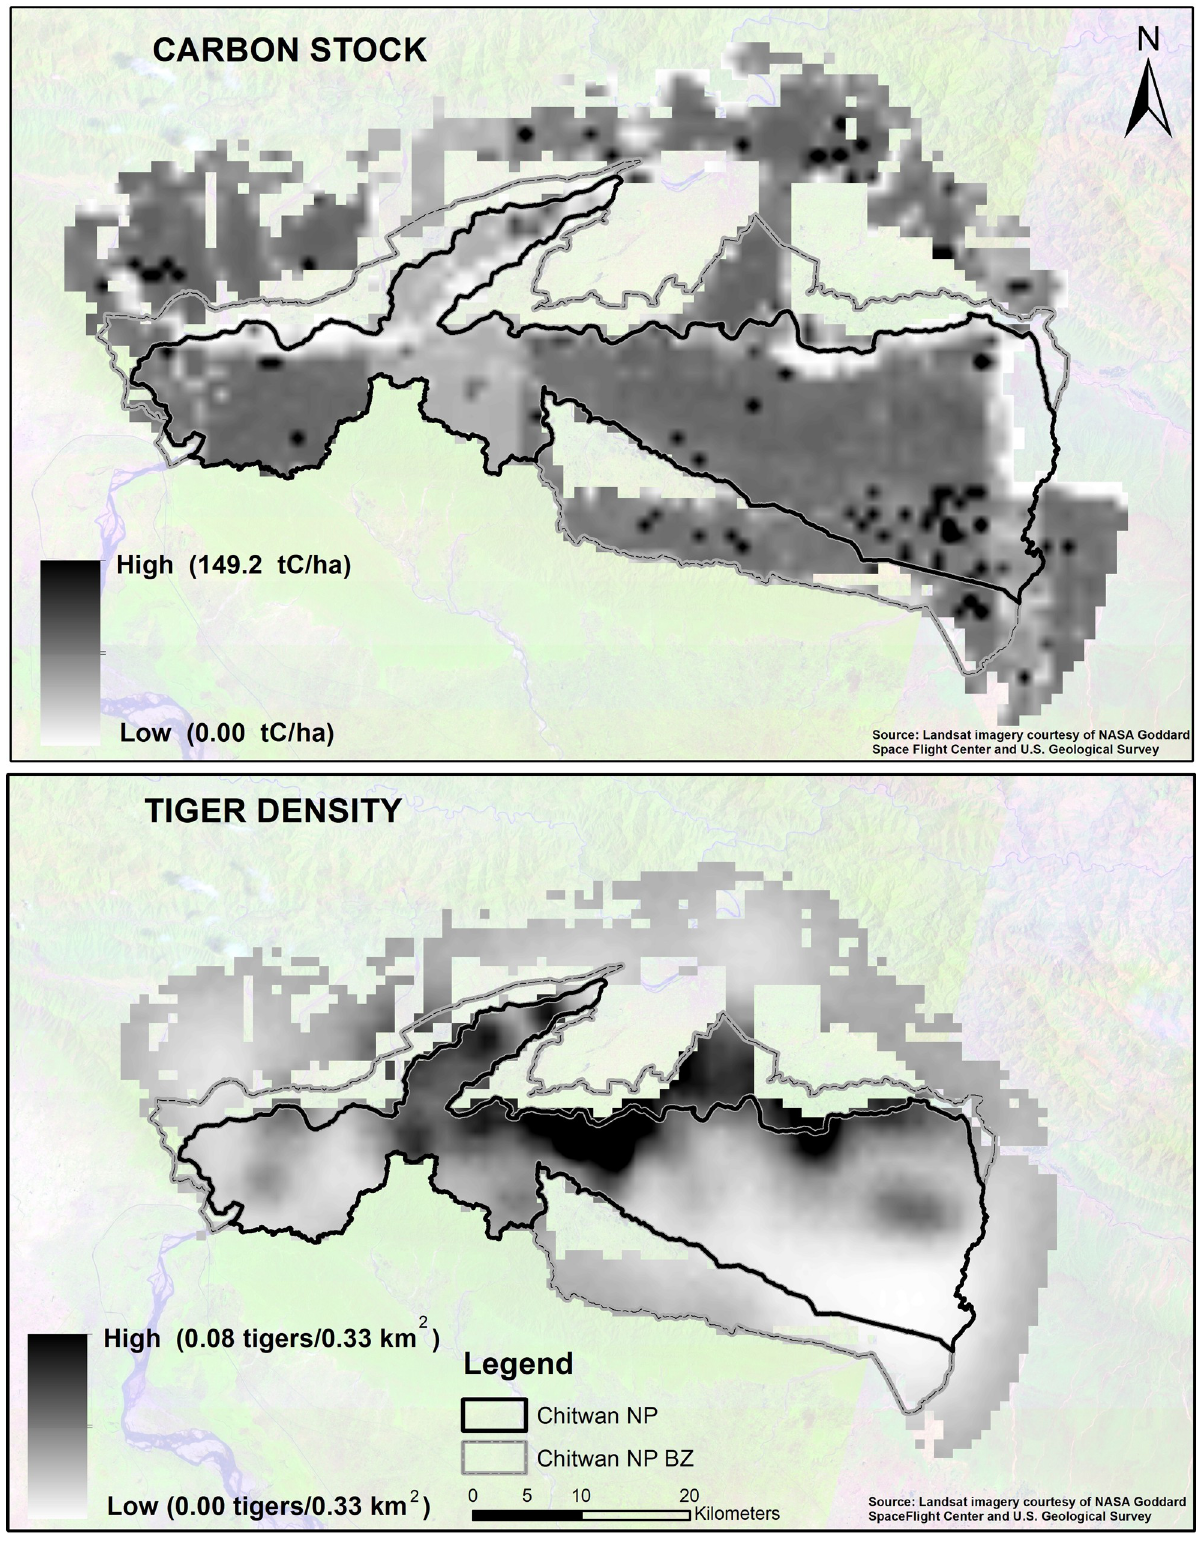
Fig 4. Pixelated density map showing above-ground biomass carbon stock distribution (top) and tiger density (bottom) in Chitwan National Park (NP) and its buffer zone (BZ). Each pixel size is 0.33 km 2 . https://doi.org/10.1371/journal.pone.0280824.g004 PLOS ONE | https://doi.org/10.1371/journal.pone.0280824 January 25,